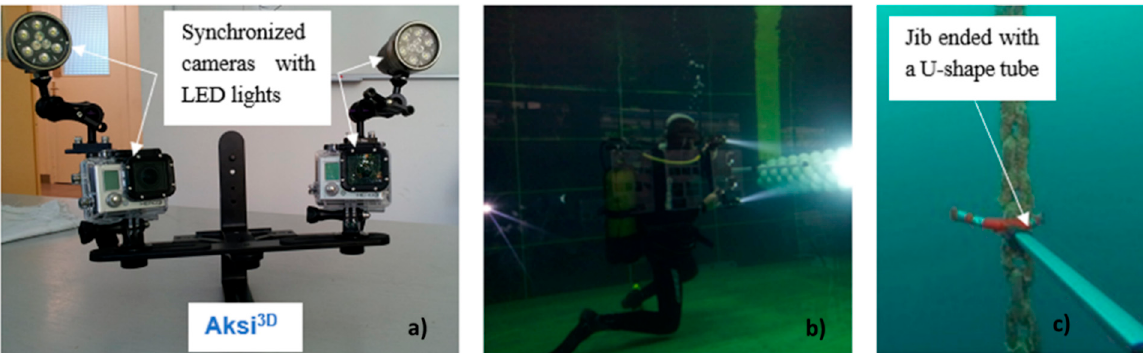
Figure 2. Aksi3D device in lab and ( a ) tested in a wave tank at Ifremer; ( b ) U-shape end of the tip; ( c ) UN-SEA test site.